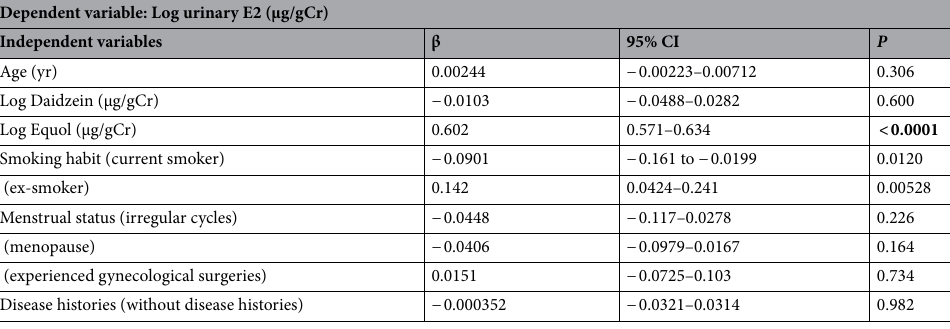
Table 5. Analysis of covariance of the association between log urinary E2 and log equol, including log daidzein, age, smoking, menstrual status and disease histories (N = 491). CI: confidence interval. Analysis of covariance was conducted for log urinary E2 as dependent variable with independent variables (log equol, log daidzein, age, smoking, menstrual status and disease histories). Tobacco use was coded as 1 = non-smoker, 2 = current smoker, and 3 = ex-smoker. Menstrual status was coded as 1 = regular cycles, 2 = irregular cycles, 3 = menopause, and 4 = experienced gynecological surgery. Disease history was coded as 1 = person with current or past disease histories, and 2 = person without disease histories. Category 1 was set as a referent. Model fitness: R 2 =